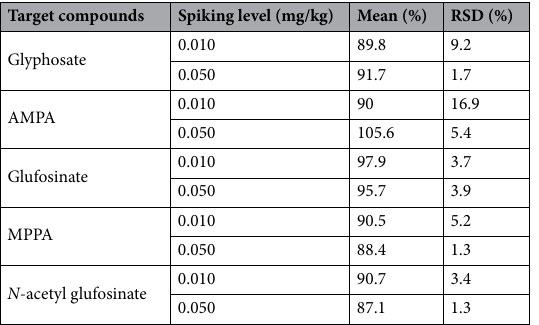
Table 3. Recoveries of five target compounds at two spiking levels of 0.01 and 0.05 mg/kg. RSD relative standard